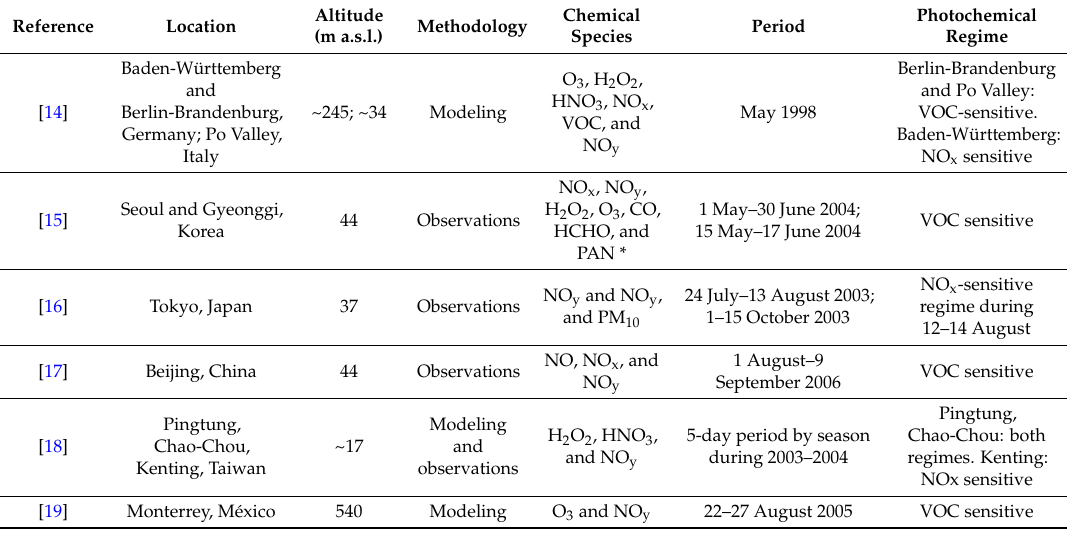
Summary of previous assessments of the O 3 production sensitivity system using photochemical